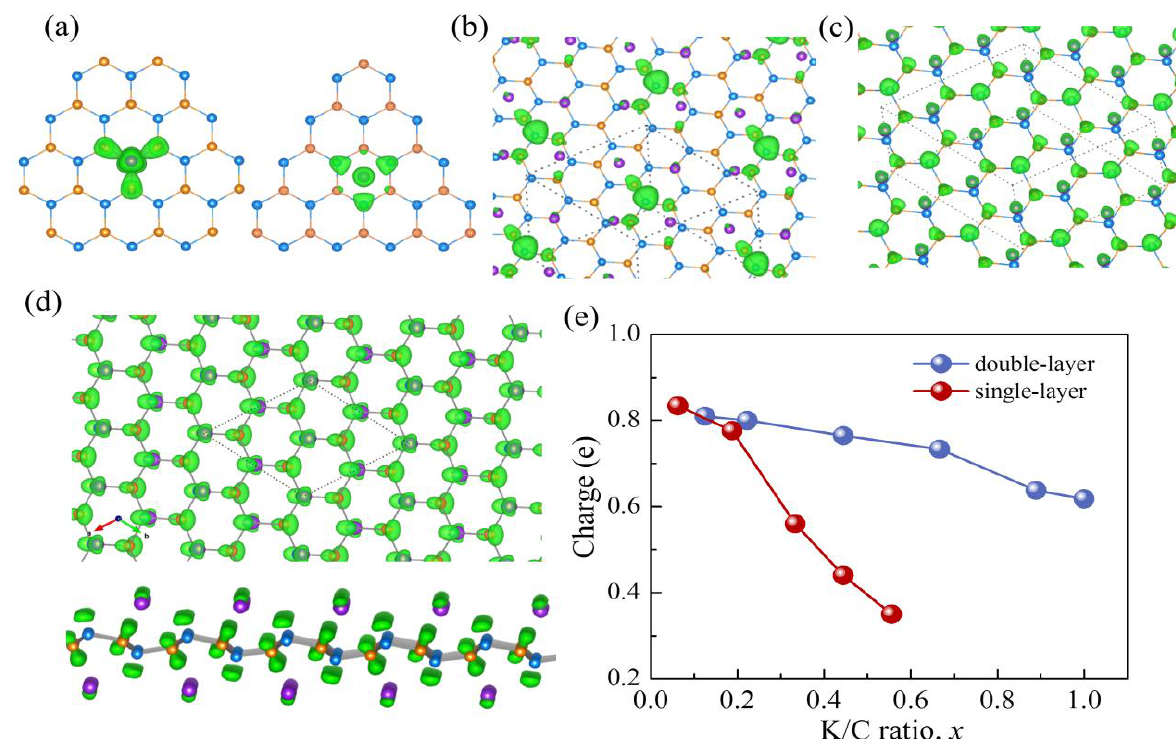
Figure 3. Distribution of electron charge density difference at the K/C ratio of ( a ) x = 0.0625 with K adsorption on H ge and H h sites in 4 × 4 × 1 supercell, ( b ) x = 0.44 and ( c ) x = 0.67 in 3 × 3 × 1 supercell, and ( d ) x = 1 with K adsorption by way of two-surface adsorption in 2 × 2 × 1 supercell, ( e ) the change of averaged charge amount that K loses with increase of K concentration. The orange, blue, and purple spheres represent C, Ge and K atoms, respectively. The green is for the transferred charge from K to g-GeC.